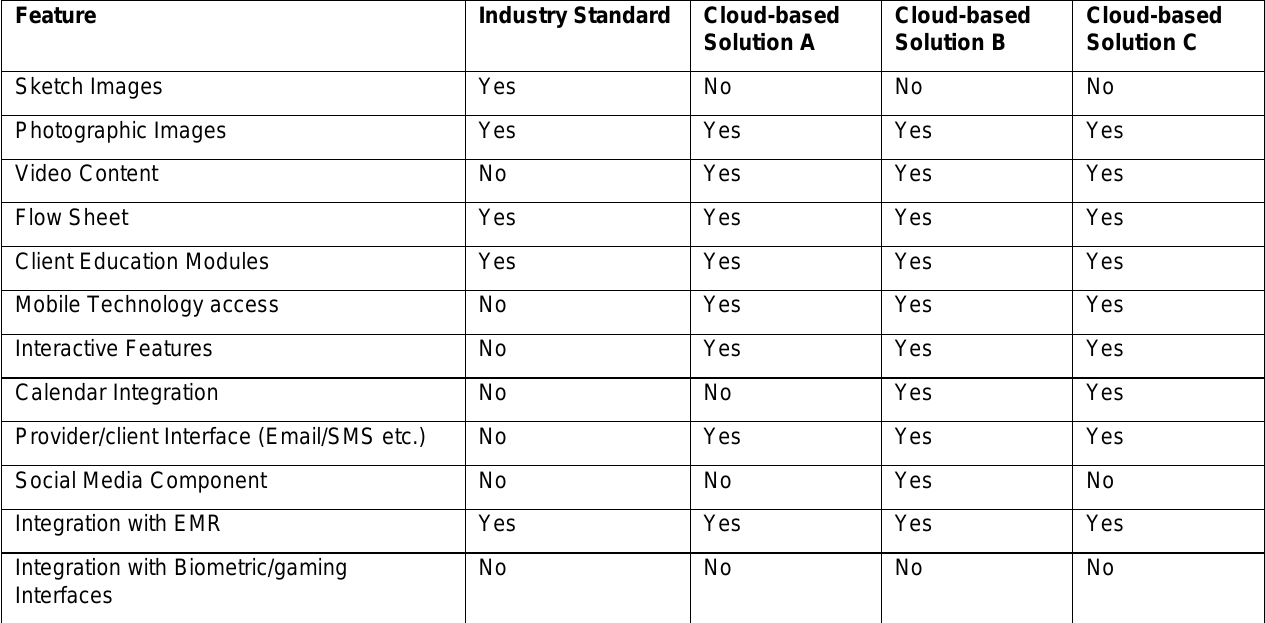
Table 3. Comparison of Cloud-Based to Non-Cloud Based Solution Features